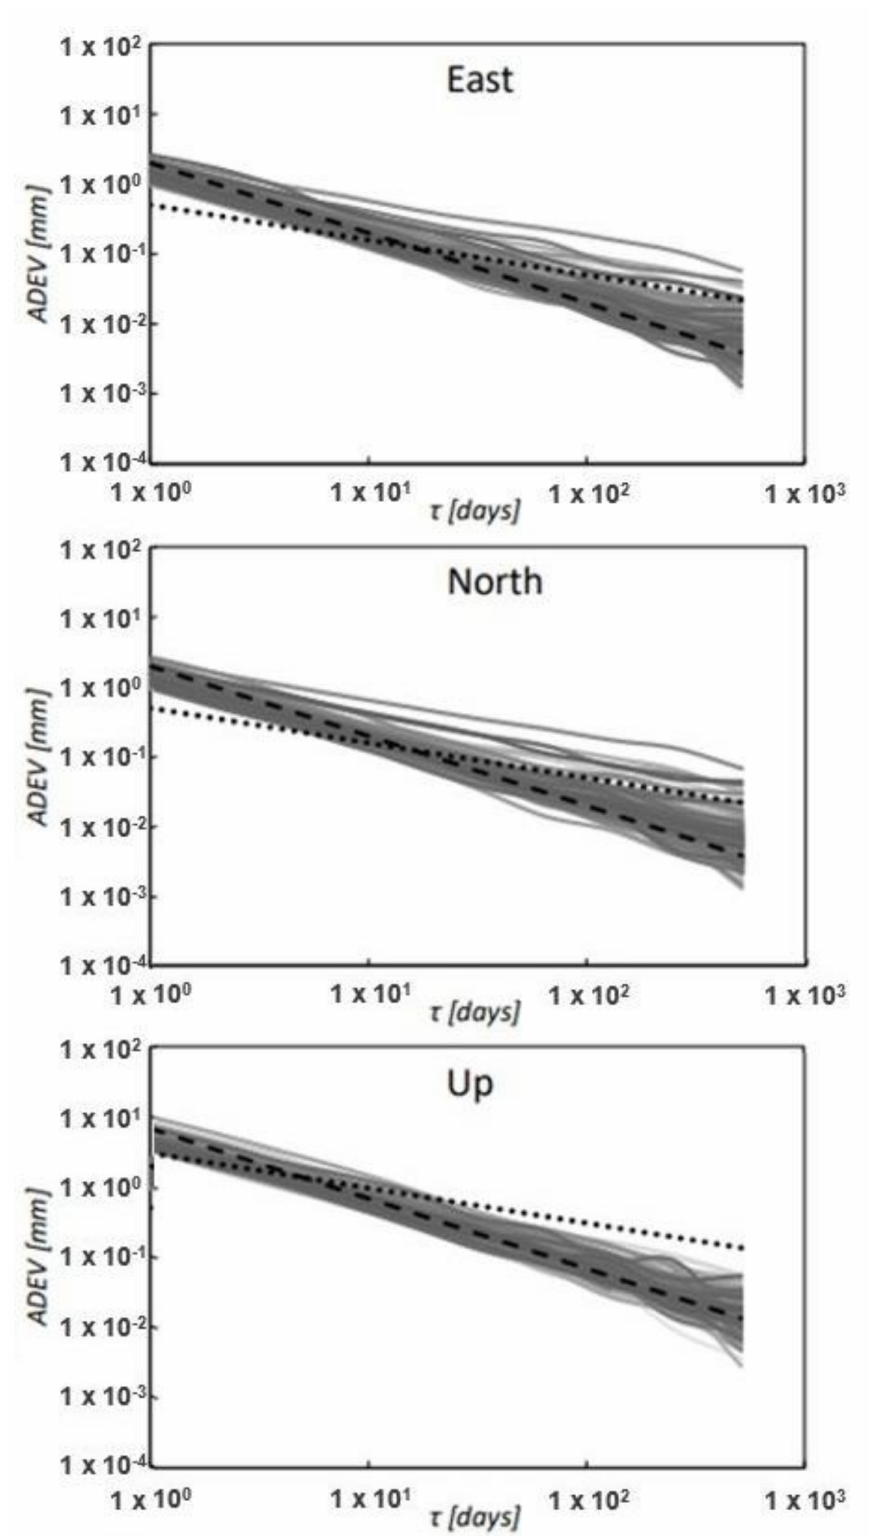
Figure 8. Combined ADEV for all analysed stations divided into East, North, and Up components. Black dashed line represents FPM (Flicker Phase Modulation) noise and black dotted line WFM (White Frequency